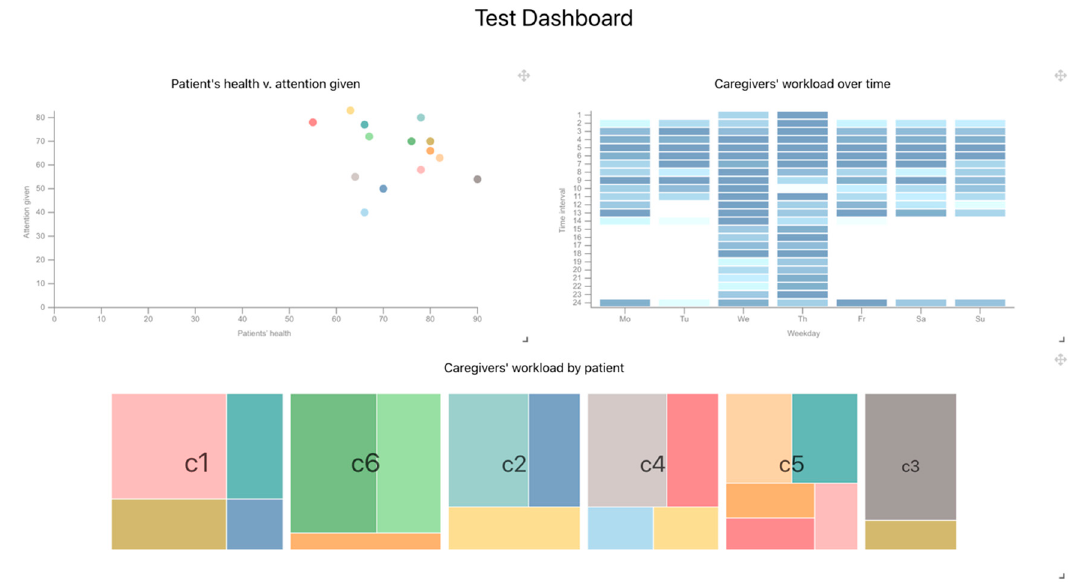
Figure 10. Screenshot of the dashboard generated through the XMI instance. Three visualizations are shown: a scatter plot that display potential relationships between the patients’ health and the attention given to them; a heatmap that display the aggregated workload of the caregivers during the different days and hours of the week; and a treemap that display the individual workload of each caregiver.